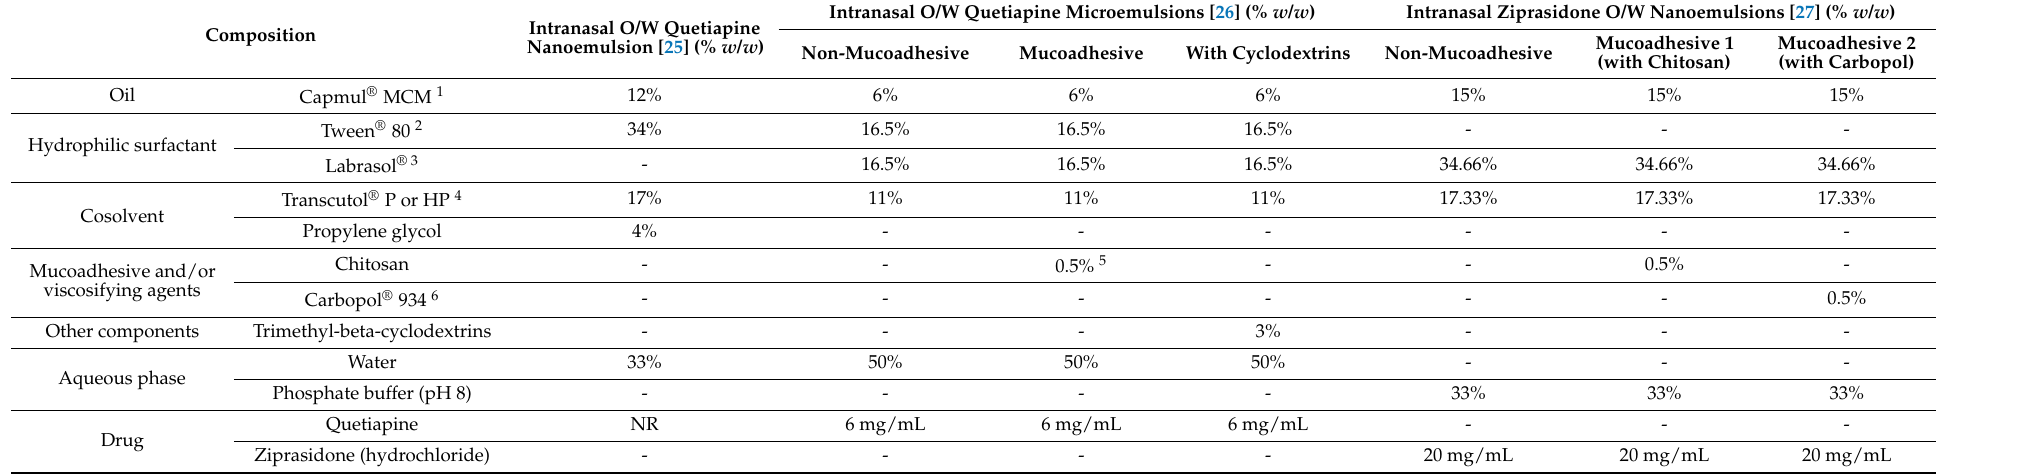
Table 5. Detailed composition of the intranasal quetiapine nano and microemulsions and intranasal ziprasidone nanoemulsions. Excipient and drug quantities and units are shown as reported in the respective articles ( w / w % for excipients, and mg/mL for drugs). For the excipients the brand name was used (when